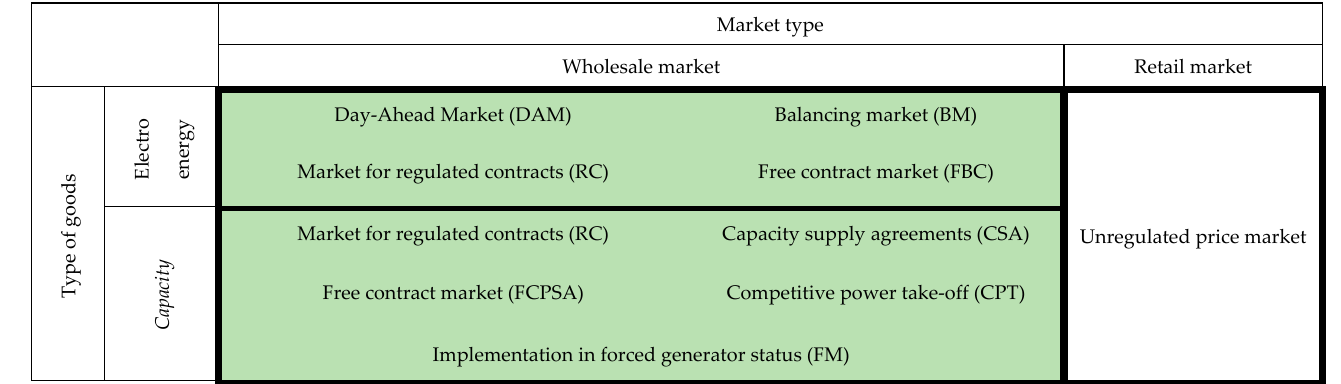
Figure 1. Structure of the Russian energy market. Source: based on [36].